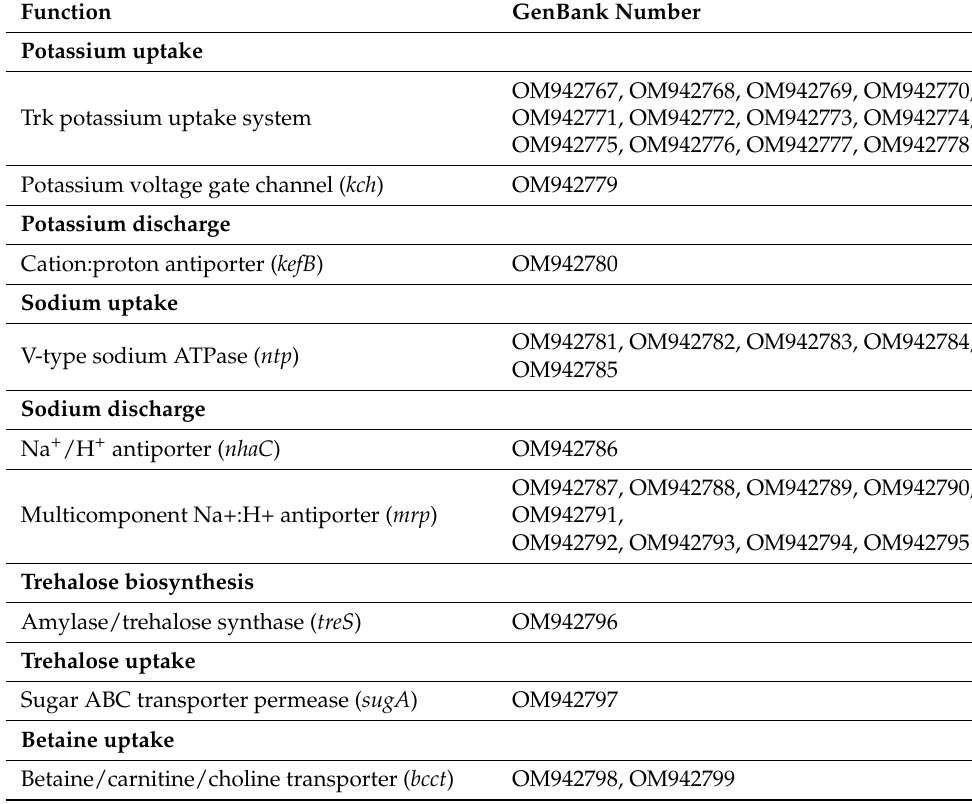
Table 2. Genes for uptake and discharge of potassium and sodium, biosynthesis and uptake of trehalose, and uptake of glycine betaine in H. kocurii 2020YC7. Function GenBank Number